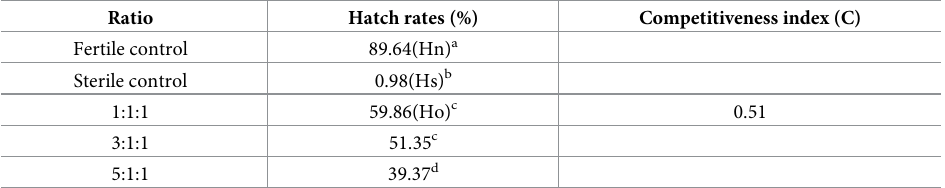
Table 2. Competitiveness index (C) of sterile Ae . aegypti males under semi field conditions in large cages, mea- sured with different ratios of sterile to untreated males. Hatch rates (%) of females as a function of the different ratios (sterile males: untreated males: virgin untreated females). Different letters indicate significant differences between the ratios (Tukey’s posthoc test P < 0.05). Hn and Hs are the hatch rate from eggs of females mated with untreated (untreated control) or sterile (sterile control) males respectively. Ho is the observed egg hatch rate for each ratio. Ratio Hatch rates